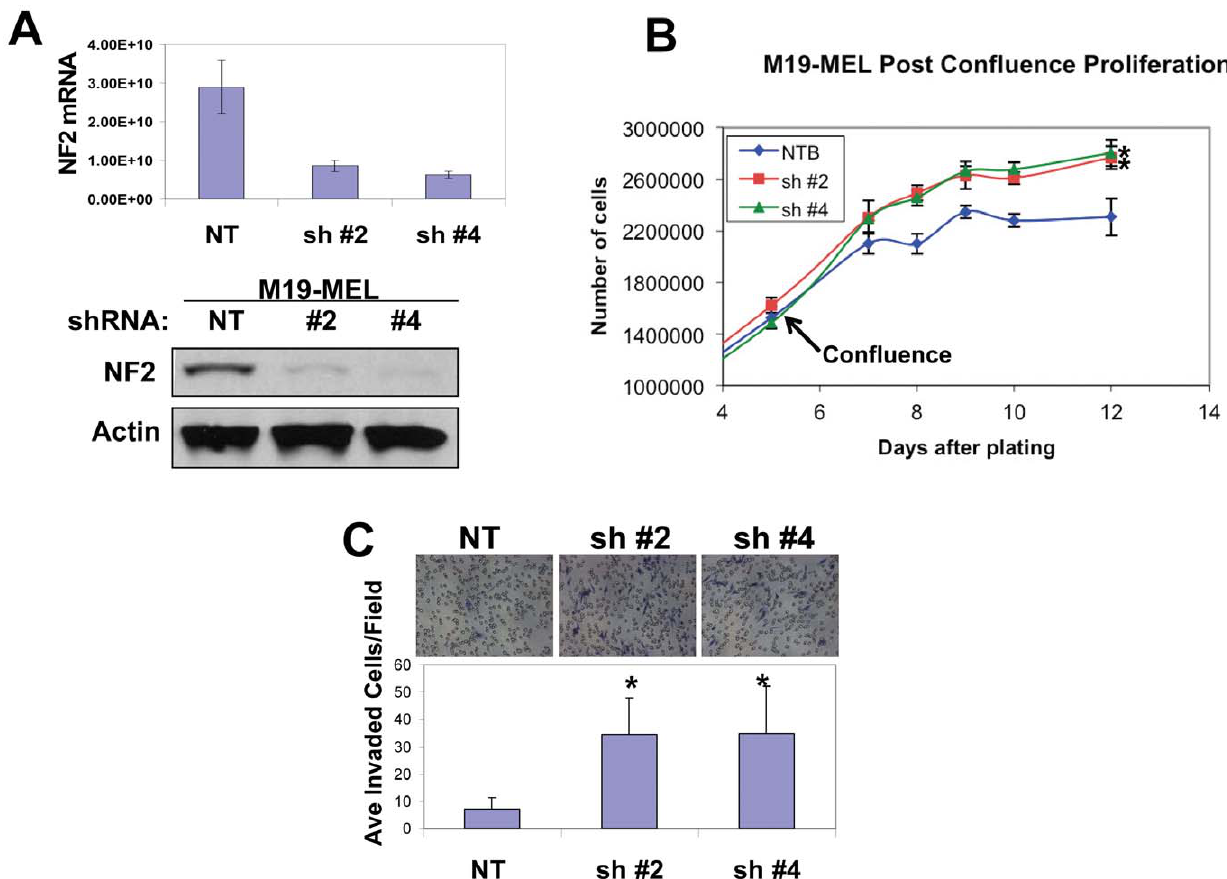
Figure 2. Merlin knockdown promotes proliferation and invasiveness of M19-MEL human melanoma cells. A , Top Panel, q-real-time RT-PCR was performed to assess merlin mRNA levels in M19-MEL cells transduced with non-targeting (NT) or merlin shRNA ( # 2 and # 4). Bottom Panel, Western blot analysis of merlin protein levels in M19-MEL cells transduced with non targeting shRNA (NT) or shRNA targeting NF2 (sh # 2 and sh # 4), actin was used as a loading control. 50 m g of protein were loaded in each lane. B , Proliferation assay of the transduced M19-MEL cells. *denotes a p -value , 0.05. C , Matrigel invasion assay of the transduced M19-MEL cells: Bars represent the mean invaded cells in 30 randomly selected 200X microscopic fields. *denotes a p -value , 0.01.